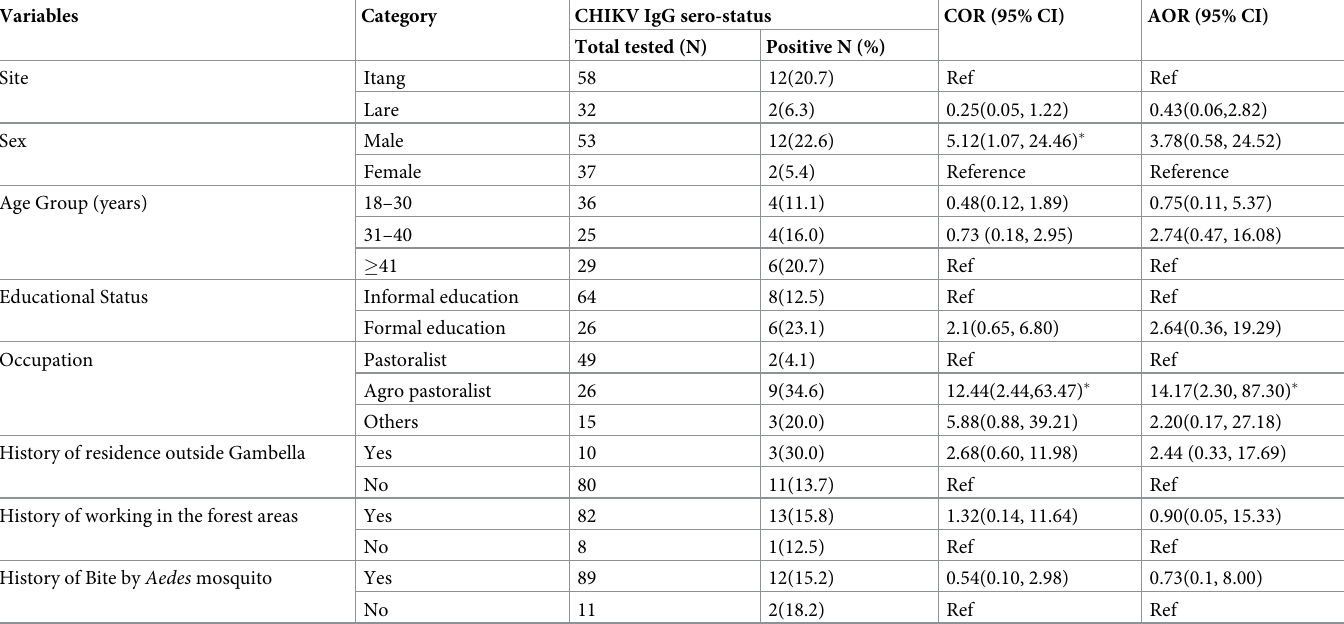
Table 3. Seropositivity for IgG antibody to CHIKV and associated factors (N = 90). Variables